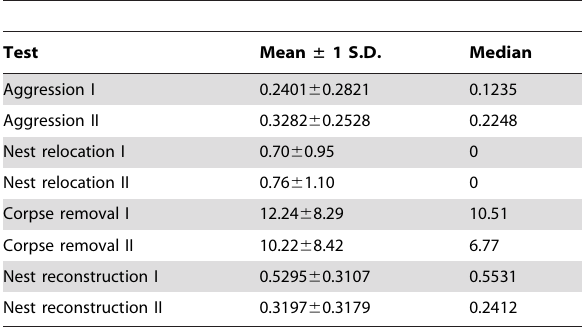
Table 1. Summary statistics for the two trials of the four behaviors observed.